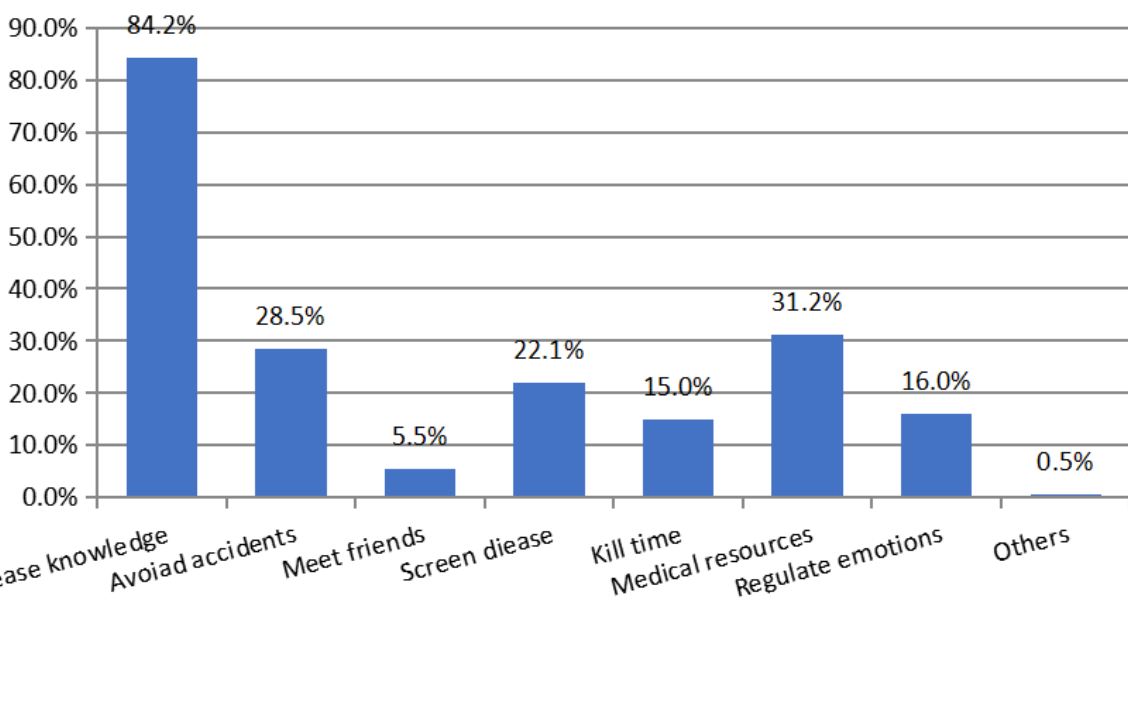
Figure 2. Benefits of using antenatal care